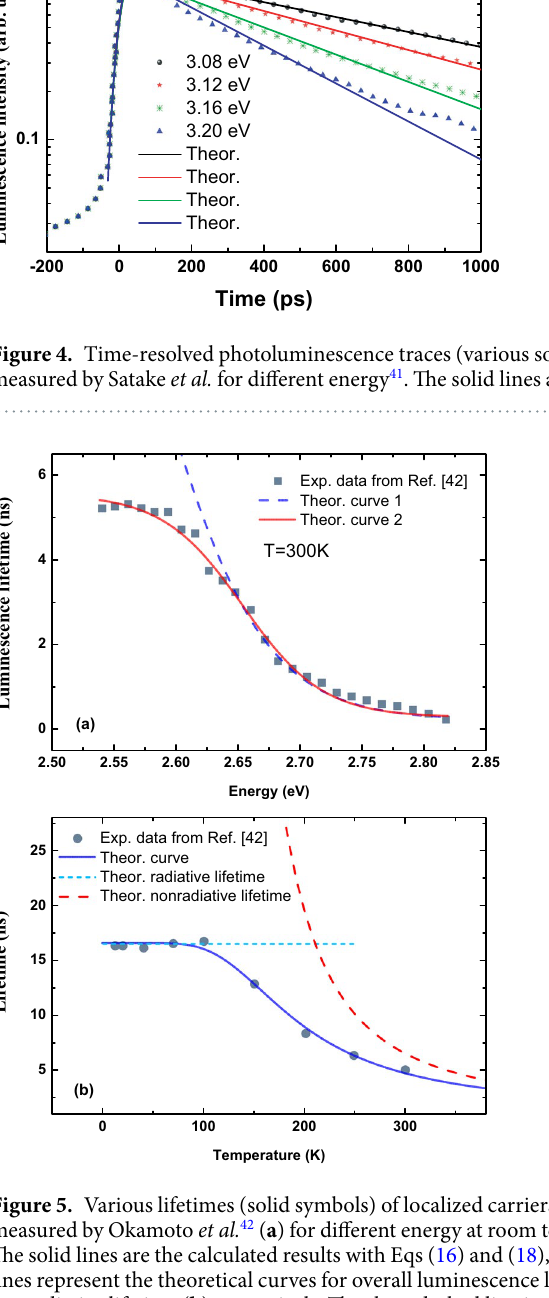
Exp. data from Ref. [42] Theor. curve